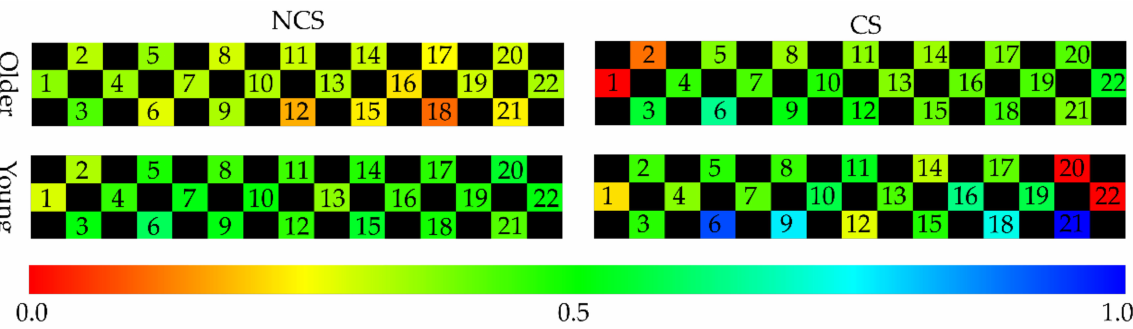
Figure 5. Heat map of brain activity when the driver feels impatient.